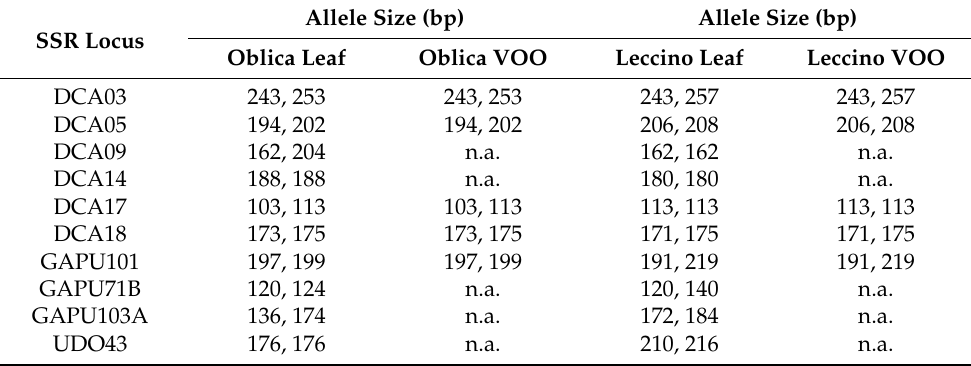
Table 7. SSR microsatellite loci and allele profile of leaves and virgin olive oils of Oblica and Leccino